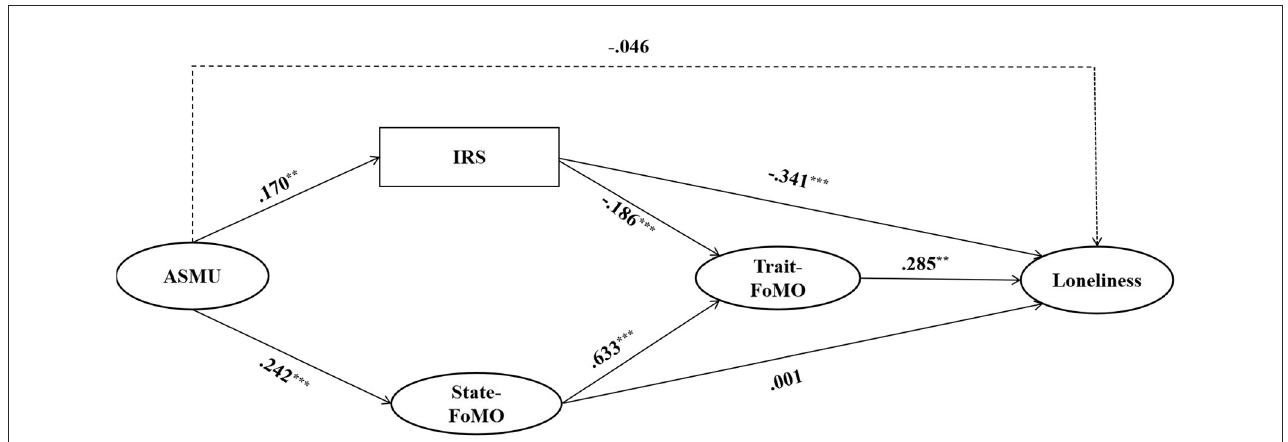
FIGURE2 Final standardized parameter values of the mode. N = 454, ** p < 0.01, *** p < 0.001. For brevity, the paths of the control variables are not shown.